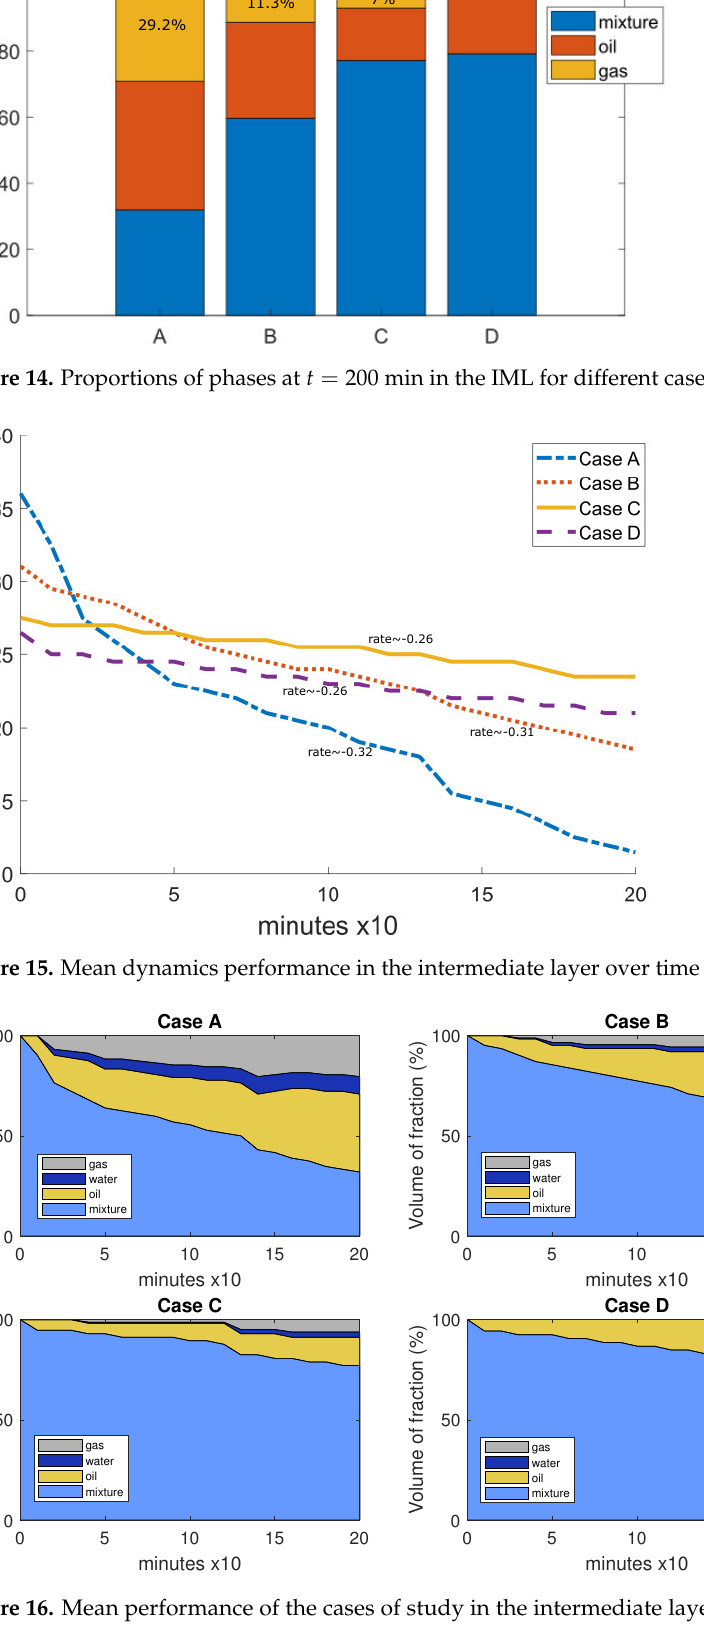
Figure 16. Mean performance of the cases of study in the intermediate layer over time. Observe a decrease in the amount of gas is observed form case A to case